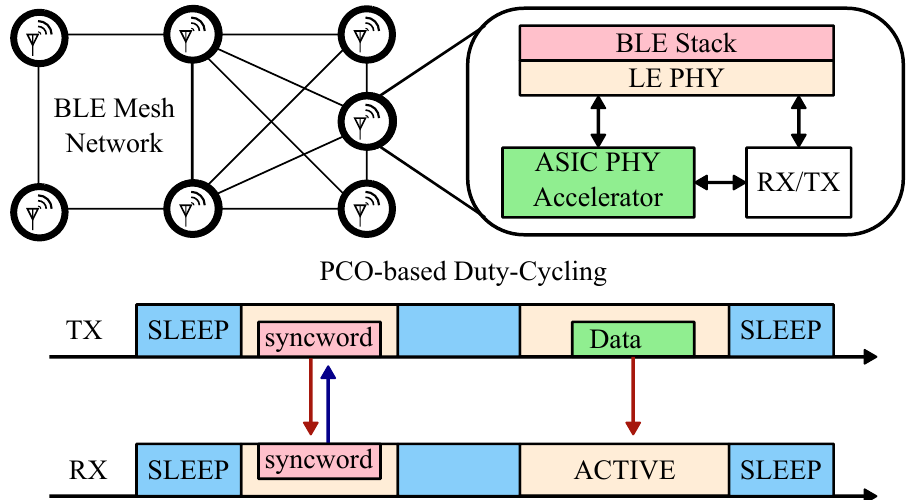
Figure 7. Proposed stack modification for scalable BLE